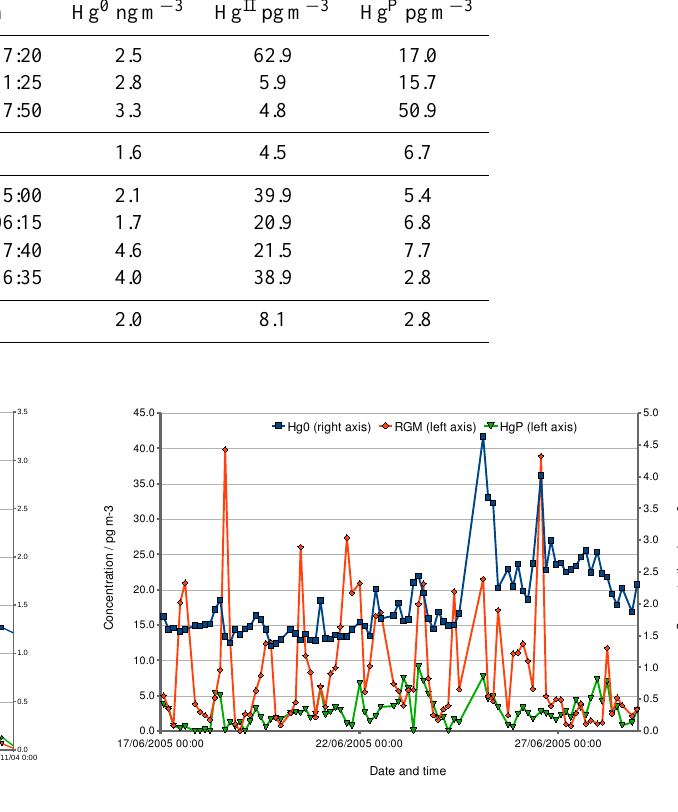
Fig. 2. The measured atmospheric Hg species concentrations during the summer 2004 oceanographic campaign.